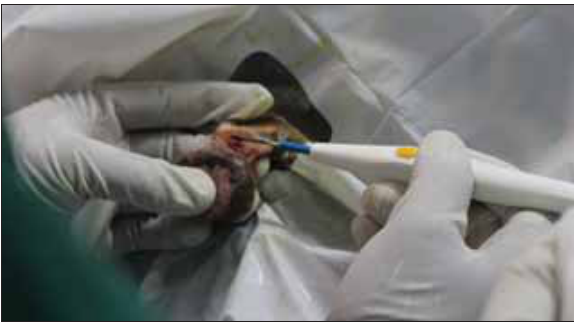
Figure-3: Surgical excision of the tumor using thermocautery.